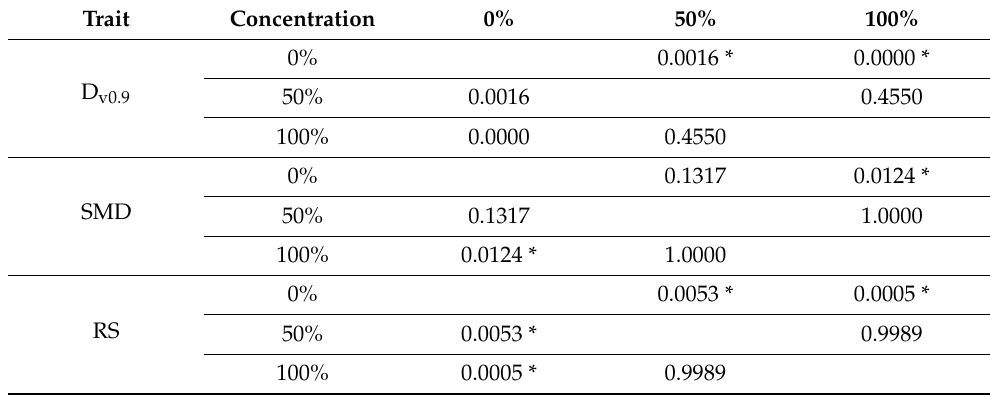
Table 6. Results of the post-hoc multiple comparison test for the concentration factor. Trait Concentration